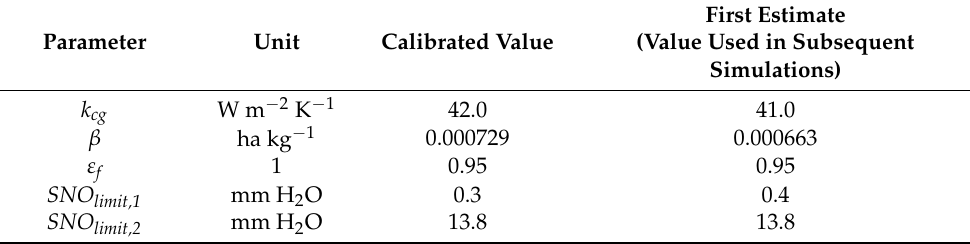
Table 3. Model parameters based on the calibration